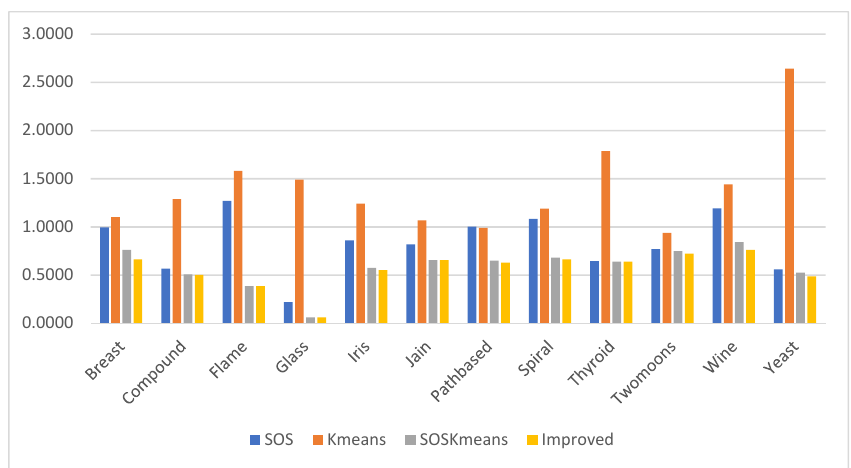
Figure 4. Performance analysis of four competing algorithms, ISOSK-means, SOSK-means, SOS and K-means, under the DB index.